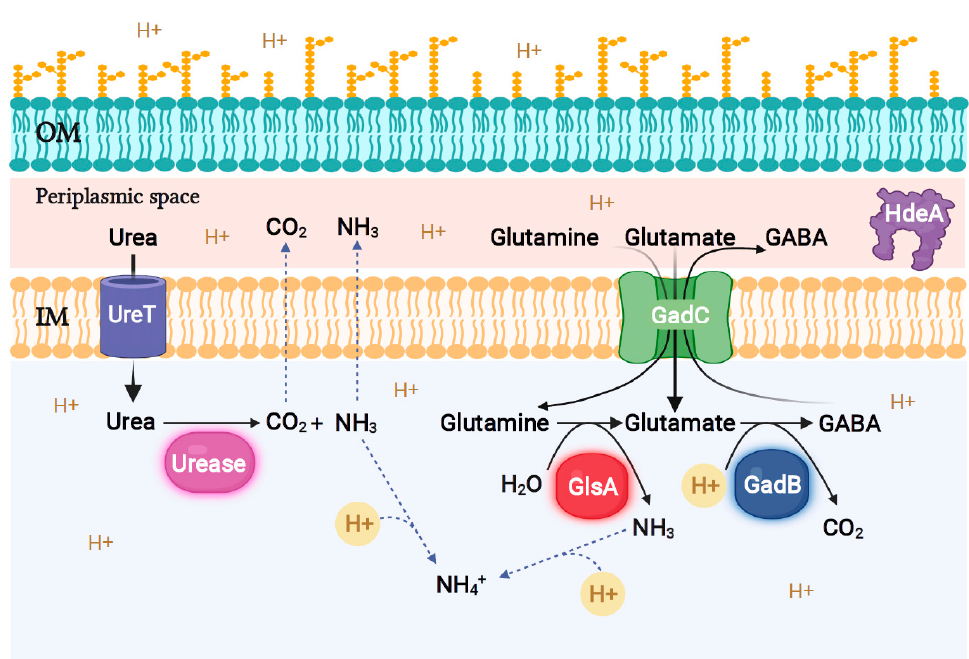
Figure 5. Schematic representation of extreme acid resistance mechanisms described in Brucella . The urease system, made up of urease and urea transporter UreT, imports and hydrolyzes urea, leading to the production of ammonia (NH 3 ) which, by capturing a proton (H + ), is converted into ammonium (NH 4+ ). The glutamate-dependent acid resistance (GDAR) system consists of two proteins: the cytoplasmic glutamate-decarboxylase GadB, and the L-glutamate (Glu)/gamma-aminobutyrate (GABA) membrane antiporter GadC. H + entry reduces intracellular pH and activates GadB that consumes H + by converting glutamate into GABA. The GadC antiporter feeds the GDAR system by exchanging charged GABA with extracellular Glu. The glutamine-dependent system consists of the L-glutamine (Gln)/Glu antiporter GadC and the glutaminase GlsA, which deaminates Gln into Glu, feeding the GDAR system and producing NH 3 , which captures a proton and is converted into NH 4 + . HdeA: chaperone protein; IM/OM: Inner and outer membrane of bacterium; The intracellular protons (H + ) consumed during the acid stress response are contained in yellow circles; Enzymatic reactions are identified by solid arrows. Created with